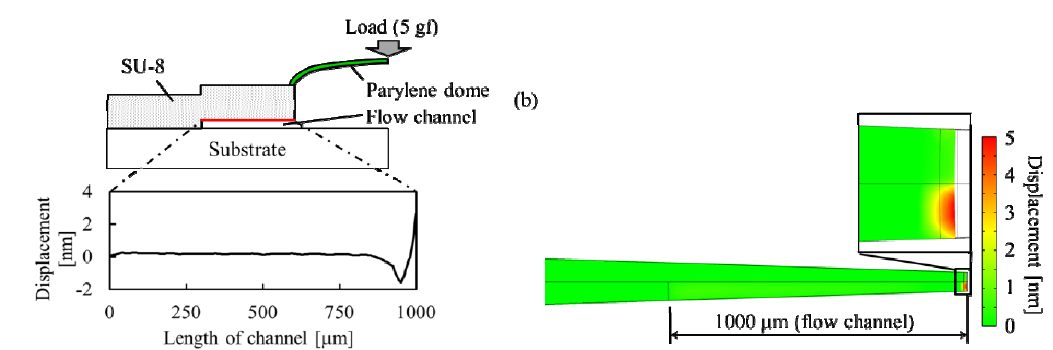
Figure 5. ( a ) Displacement of flow channel line. ( b ) Displacement of flow channel